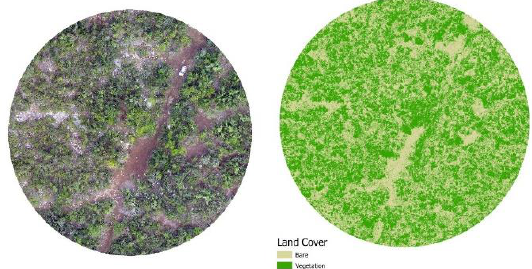
Figure 9: Comparison of land cover using unclassified supervision with the original drone photography. The diameter of the area is 100 meters.